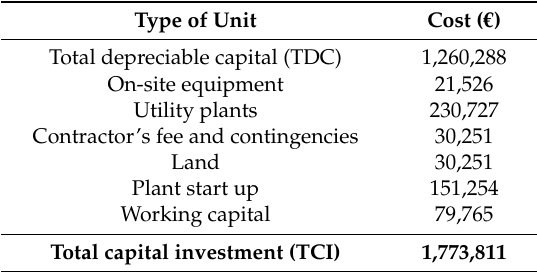
Table 5. Total capital investment for HTC plant.